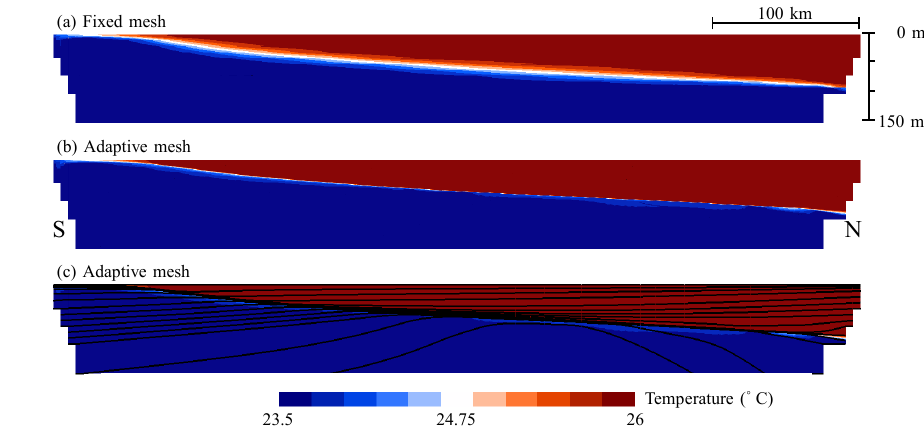
Figure 13. Temperature profile using the uniform wind on 8 July 1993, with the 2-D x - z model, with a fixed mesh (a) and an adaptive mesh (b,c) having an equal number of elements. Panel (c) also shows the levels position for the moving mesh simulation.